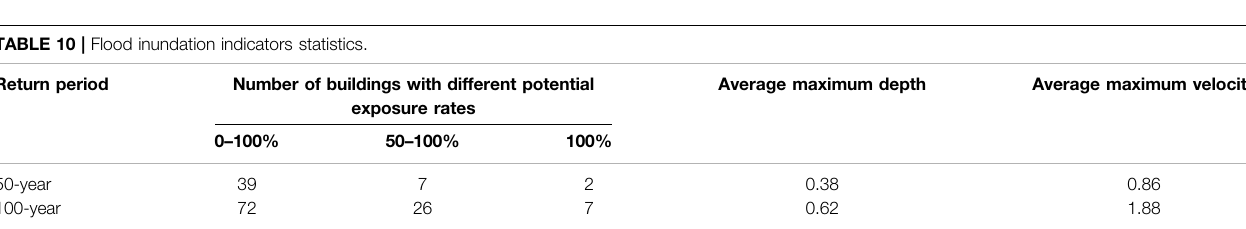
TABLE 10 | Flood inundation indicators